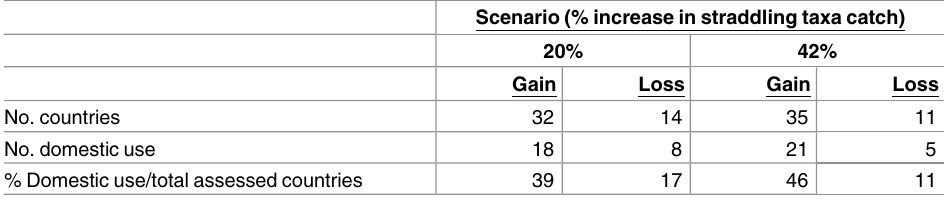
Table 2. Number of countries with projected gains and losses under each high seas catch scenario, and the corresponding number of countries which consume straddling fish taxa domestically (denoted by No. domestic use).